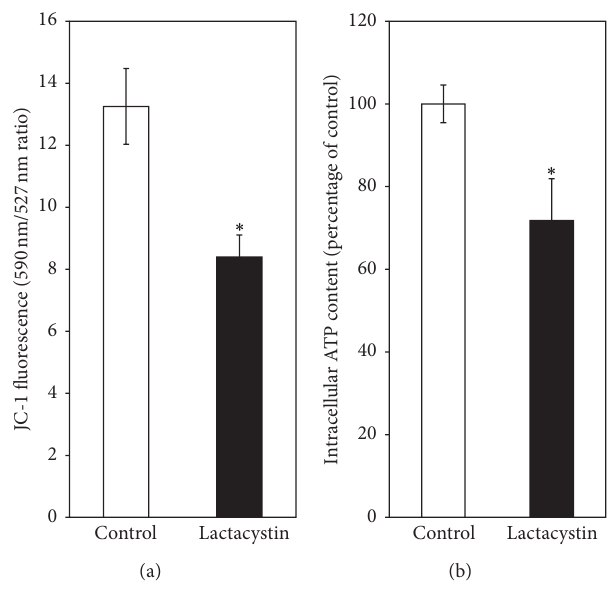
Figure 6: Lactacystin effects on mitochondrial functions in SH- SY5Y cells. SH-SY5Y cells were exposed to lactacystin (5 𝜇 M) for 24 h followed by the measurement of (a) mitochondrial mem- brane potential and (b) intracellular ATP content, as described in Section 3. Values are the means ± SD of six observations. Student’s 𝑡 -test, paired, shows significant difference ( ∗ 𝑃 < 0.001 ) in the mitochondrial membrane potential between the lactacystin-treated group (M = 8.39, SD = 0.71) and the control group (M = 13.25, SD = 1.22); 𝑡 (5)=12.81(a).Similarly,asignificantdifference( ∗ 𝑃 < 0.01 )in the ATP content between the lactacystin-treated group (M = 71.79, SD = 10.08) and the control group exists; 𝑡 (5) = 3.79